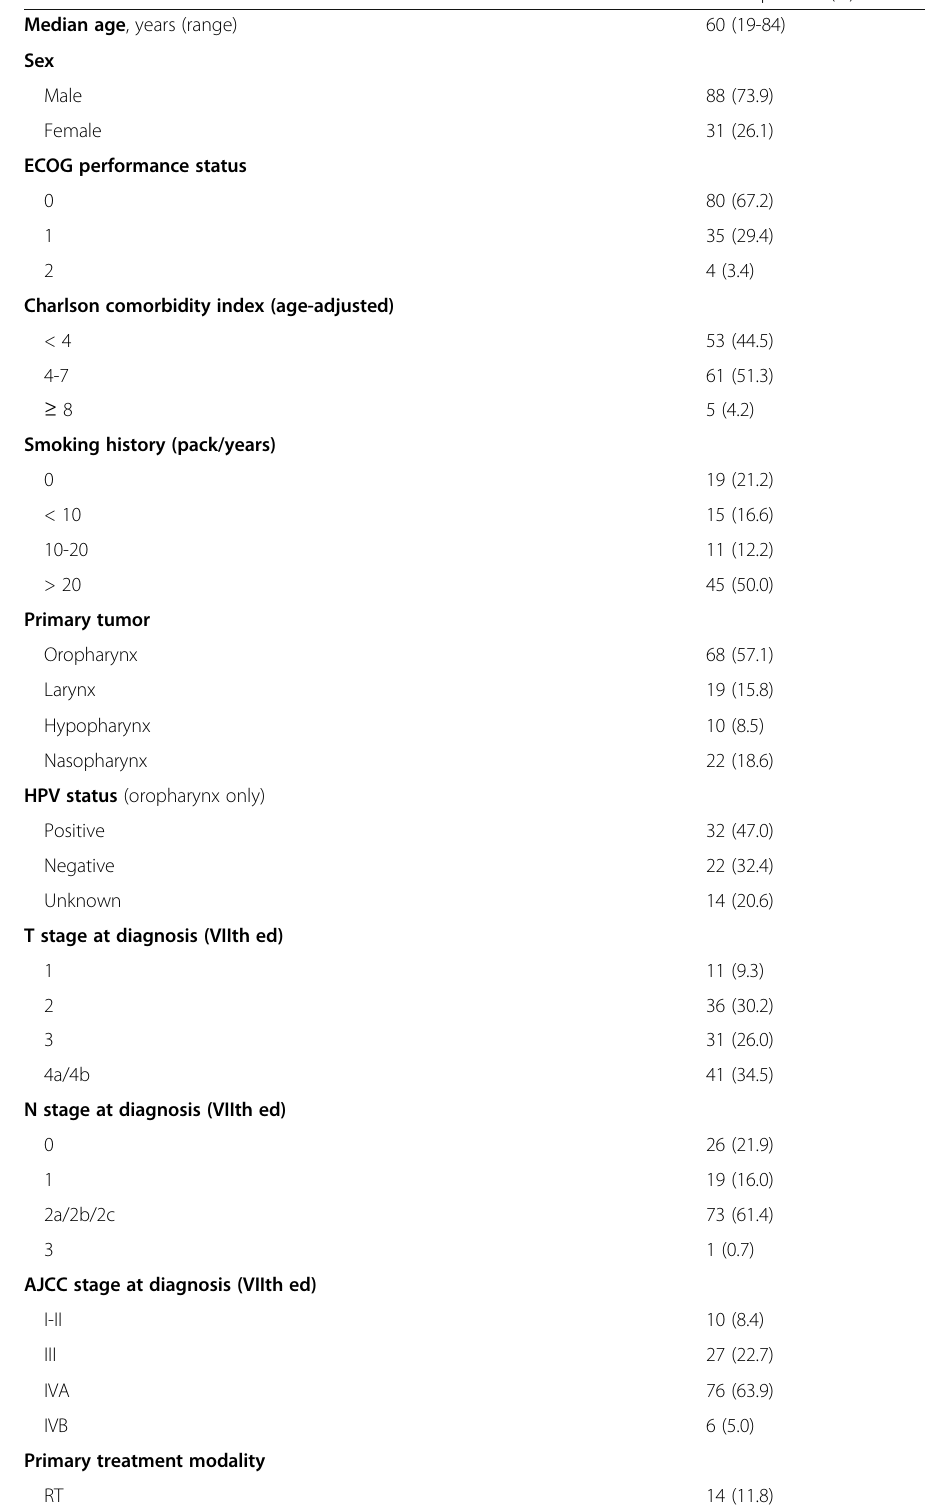
Table 2 Patients ’ disease and treatment